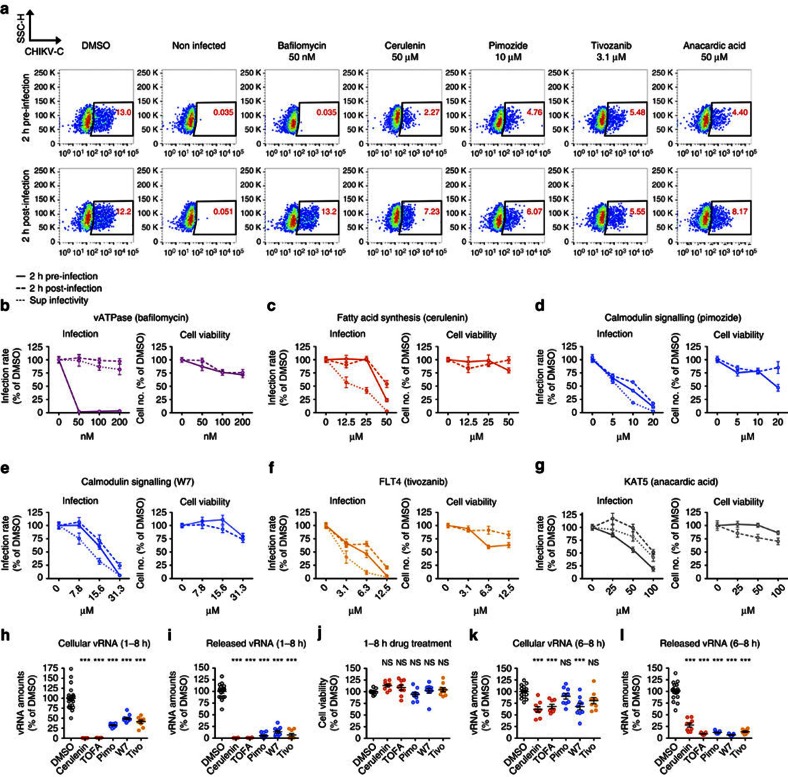
In vitro validation of selected chemical inhibitors and proviral factors.(a–g) Infection rate and cell viability for compounds specific to vATPase (bafilomycin, n=12, 6, 12 and 6 for all conditions at increasing concentrations), calmodulin (pimozide, n=12, 12, 12 and 9 for all conditions at increasing concentrations and W7, n=9 for all data sets), fatty acid synthesis (cerulenin, n=9, 6, 6 and 9 for all conditions at increasing concentrations), FLT4 (tivozanib, n=12, 6, 9 and 12 for all conditions at increasing concentrations) and KAT5 (anacardic acid, n=9 for all data sets) administrated to CHIKV-infected HEK-293T cells as indicated. Cells were treated 2 h before (solid lines) or 2 h after (dashed lines) infection with CHIKV C21 (MOI 40) and left until 8 h p.i. to avoid multiple cycles of infection. Viral infectivity and cell viability were then measured by flow cytometry after intracellular staining of CHIKV capsid (CHIKV-C, see a for an example). Equal amounts of supernatants from the 2 h post treatment conditions were measured for viral infectivity on Vero cells (dotted lines) to detect eventual defects in viral release. (h,i) Quantitative PCR with reverse transcription quantification of cell- (n=20, 9, 9, 12, 12 and 9 in displayed order) (h) and supernatant-associated (n=18, 6, 6, 12, 12 and 9 in displayed order) (i) vRNA performed on RNA extracts of HeLa cells infected with CHIKV C21 (MOI: 50) for 1 h and treated with cerulenin (50 μM), TOFA (25 μM), pimozide (pimo, 10 μM), W7 (20 μM), tivozanib (tivo, 5 μM) or vehicle alone for an additional 7 h. (j) Cell viability measured at the end of the experiment shown in h, using the CellTiter-Glo kit (n=9 for all data sets). (k,l) Cell- and supernatant-associated vRNA measured on CHIKV-infected HeLa cells treated with the indicated drugs from 6 to 8 h p.i. (n=18, 9, 8, 9, 9 and 9 for m and n=18, 9, 9, 9, 9 and 9 for n in displayed order). Data represent mean+s.e.m. of at least three independent experiments, analysed by one-way analysis of variance with Tukey's post test (***P<0.001; NSP≥0.05).